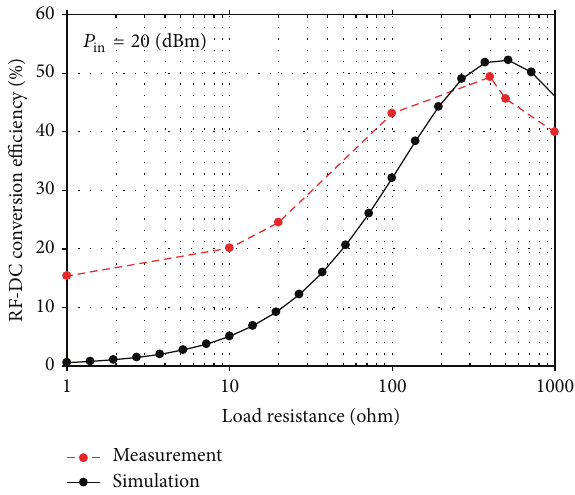
Figure 5: Simulated and measured load resistance characteristics of RF-DC conversion efficiency.